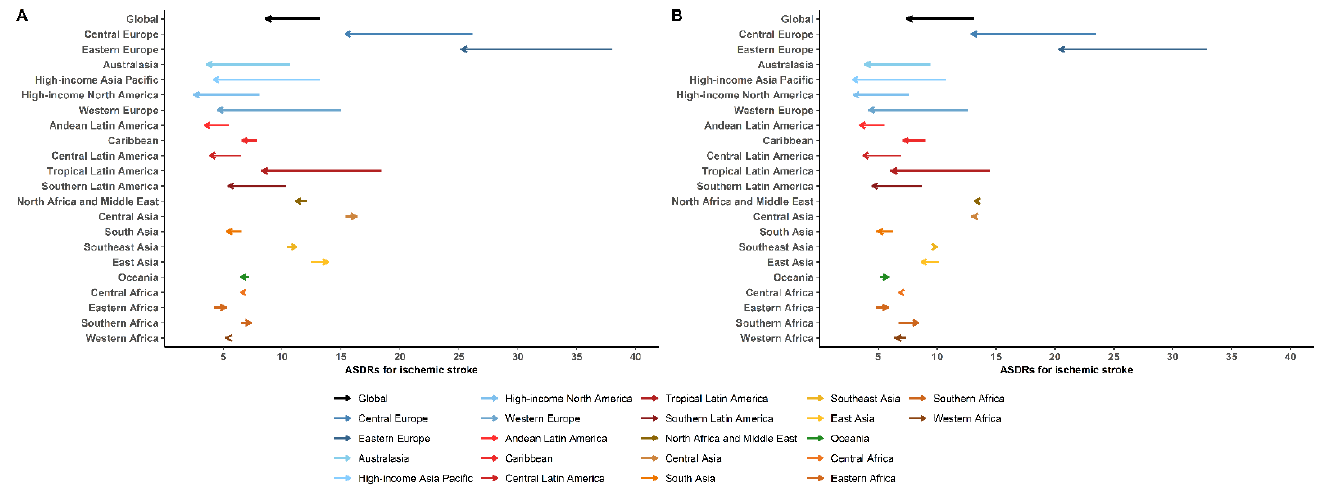
Figure 5. Change in age-standardized death rates per 100,000 of the general population from ischemic stroke attributable to high low-density lipoprotein cholesterol between 1990 and 2019 by region for men ( A ) and women ( B ). Data obtained from GBD database available on https://vizhub.healthdata. org/gbd-results/ (accessed on 1 July 2022) [14]. Abbreviations: ASDRs, age-standardized death